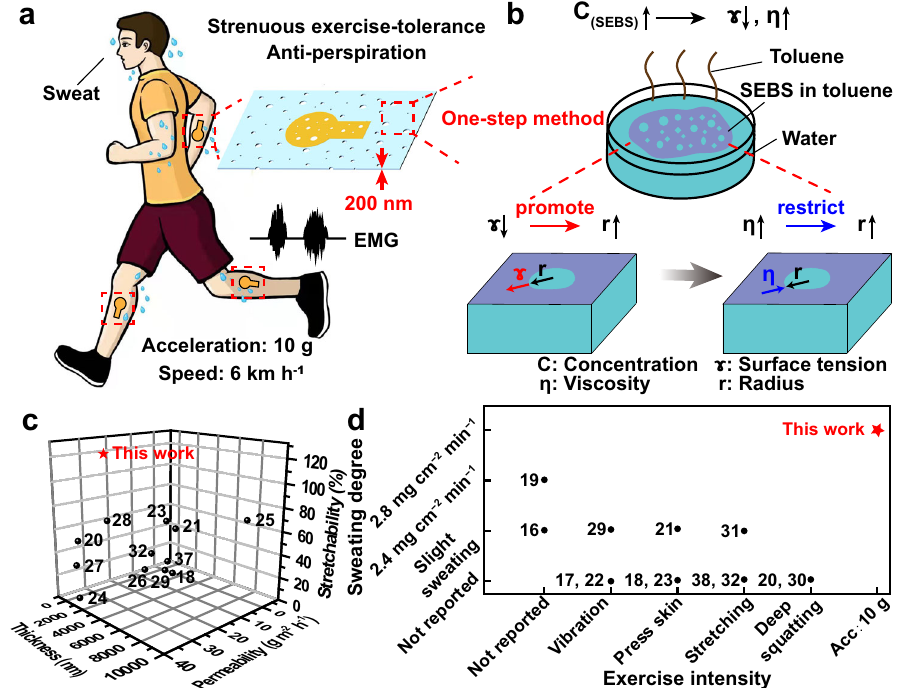
Fig. 1 Features and superiorities of the electrode. a Schematic illustration showing the ultrathin porous stretchable electrode with good strenuous exercise-tolerance and anti-perspiration properties. b Fabrication process of the ultrathin porous stretchable fi lm depending on the Marangoni effect. c Thickness, permeability, and stretchability comparison between the electrodes reported in the literature and the one in this work. d Comparison of the strenuous exercise-tolerance and anti-perspiration between the electrodes reported in the literature and the one in this